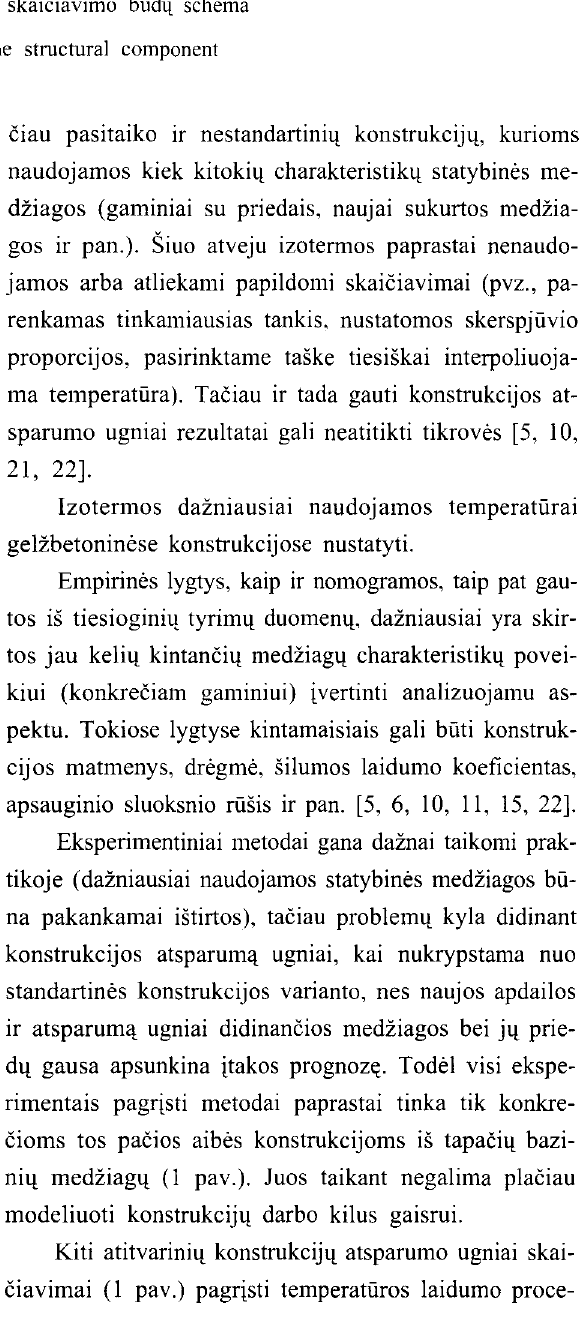
Fig 1. Different temperature calculation methods within the structural component